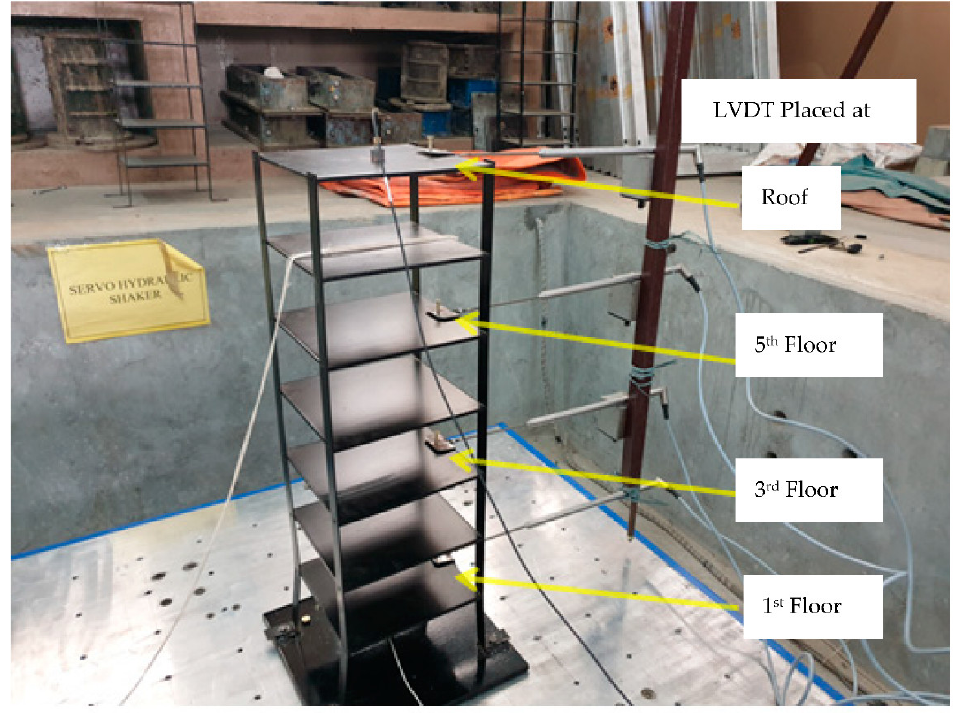
Figure 5. Shake-table test for the fixed-base structure.